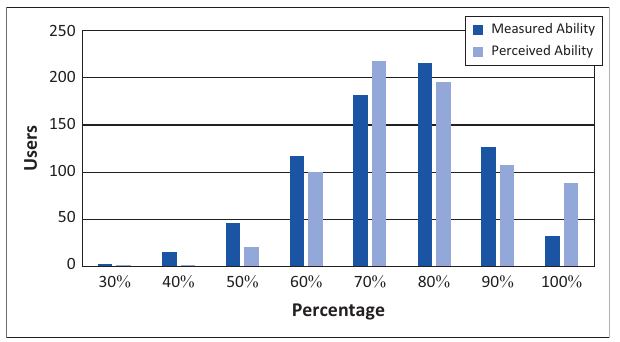
FIGURE 9: Comparison of respondents’ perceived ability and measured ability.